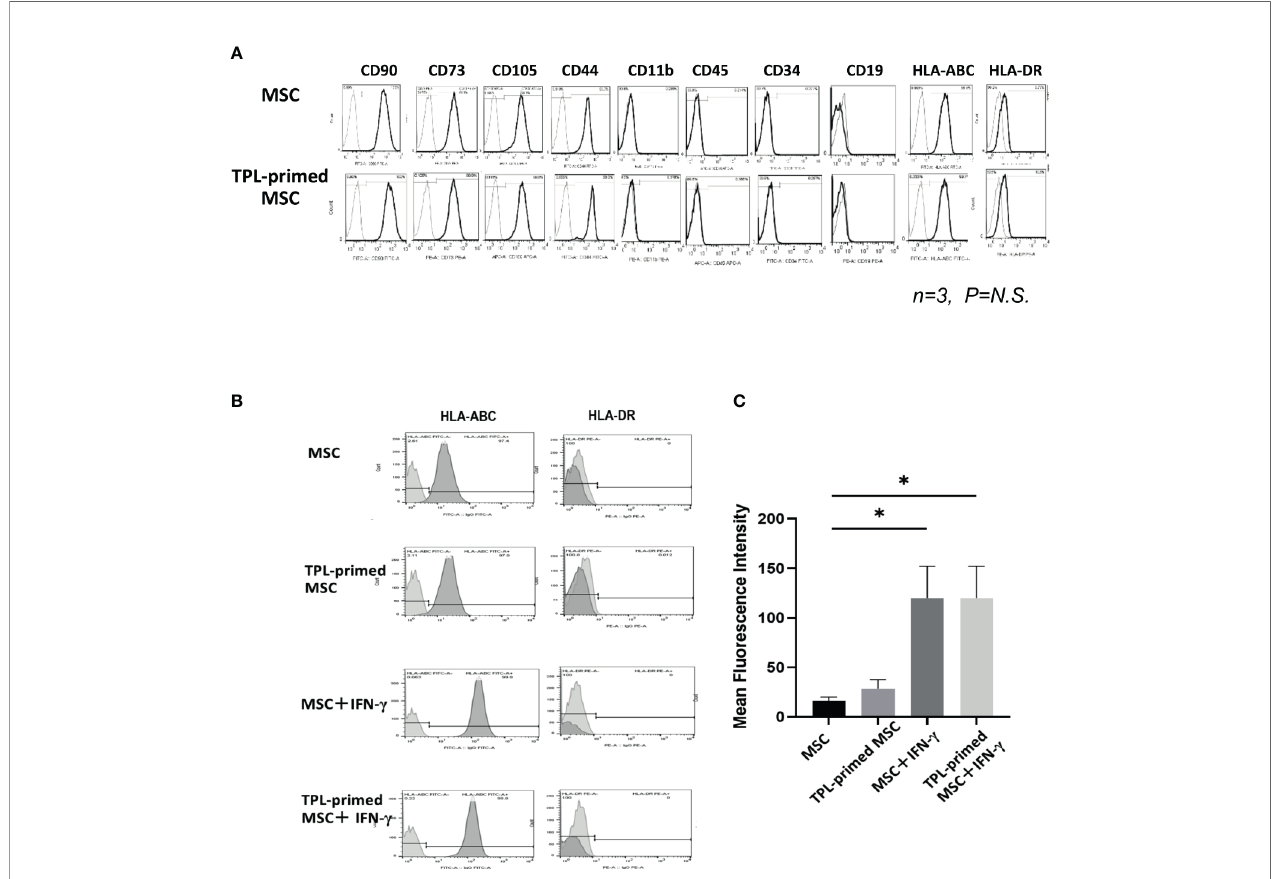
FIGURE 2 | The surface markers of TPL-primed UC-MSCs. (A) TPL-primed UC-MSCs express the same surface markers as the UC-MSCs which are positive for CD90, CD73, CD105, CD44, and HLA-ABC, and negative for CD34, CD45, CD11b, and HLA-DR. Mean fl uorescent intensity (MFI) of surface marker on MSCs and TPL- primed MSC is shown. There are no signi fi cant differences of MFI between TPL-primed UC-MSC (+) and non-primed UC-MSC (-). (B) Surface markers of HLA-ABC and HLA-DR in TPL-primed UC-MSCs and UC-MSCs with or without IFN- g . (C) Quantitative analysis of mean fl uorescent intensity HLA-ABC in TPL-primed UC-MSCs and UC-MSCs with or without IFN- g . Quantitative data have been presented as the mean value of three different samples ± SD with *p <